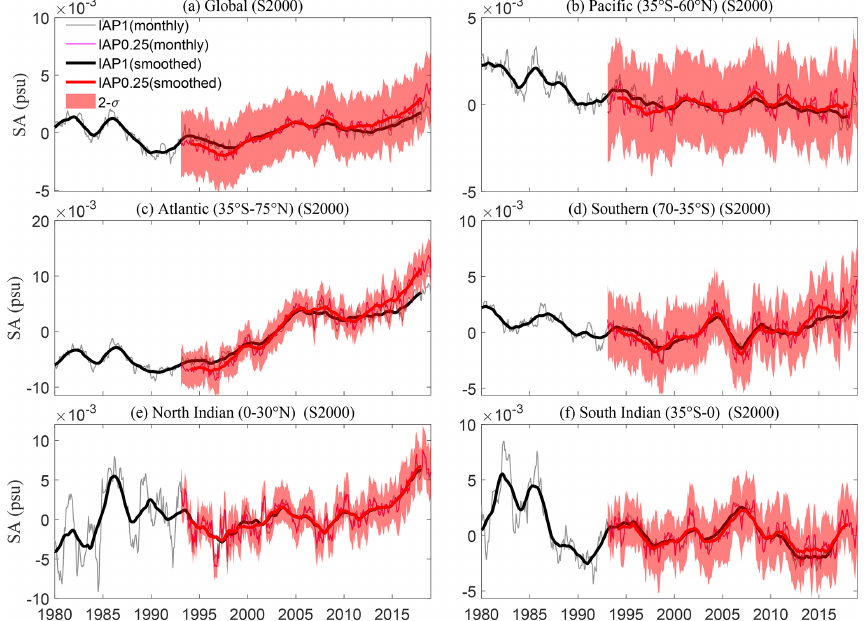
Figure 15. The global (a) and basinal (b–f) 1–2000m averaged salinity anomalies (SA) time series from 1993 to 2018 for IAP1 ◦ and IAP0.25 ◦ respectively. Both monthly and 12-month running smoothed time series are presented; all data are relative to a 1993–2015